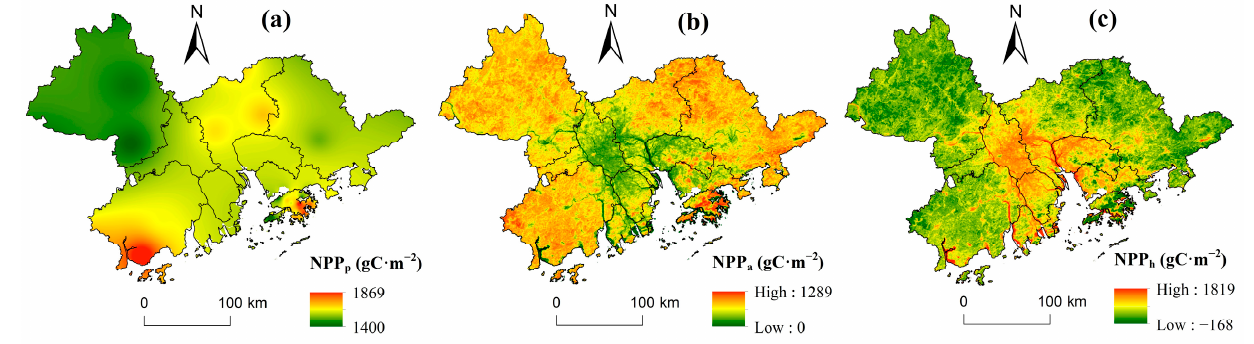
Figure 4. Spatial patterns of mean annual ( a ) NPP p , ( b ) NPP a , and ( c ) NPP h from 2000 to 2020. The NPP a spatial distribution was heterogeneous (Figure 4b) due to the variable land cover and human activity intensity values. NPP a values were low in central areas and high in surrounding regions, with a mean value of 606.37 gC · m − 2 · yr − 1 during the study period. The lowest values were primarily distributed in the central areas of the GBA, such as Foshan, Zhongshan, southern Guangzhou, western Dongguan, western Shenzhen, and Zhuhai. These areas were dominated by impervious surfaces and other non-vegetated areas, with mean values < 200 gC · m − 2 · yr − 1 . In contrast, the highest values (greater